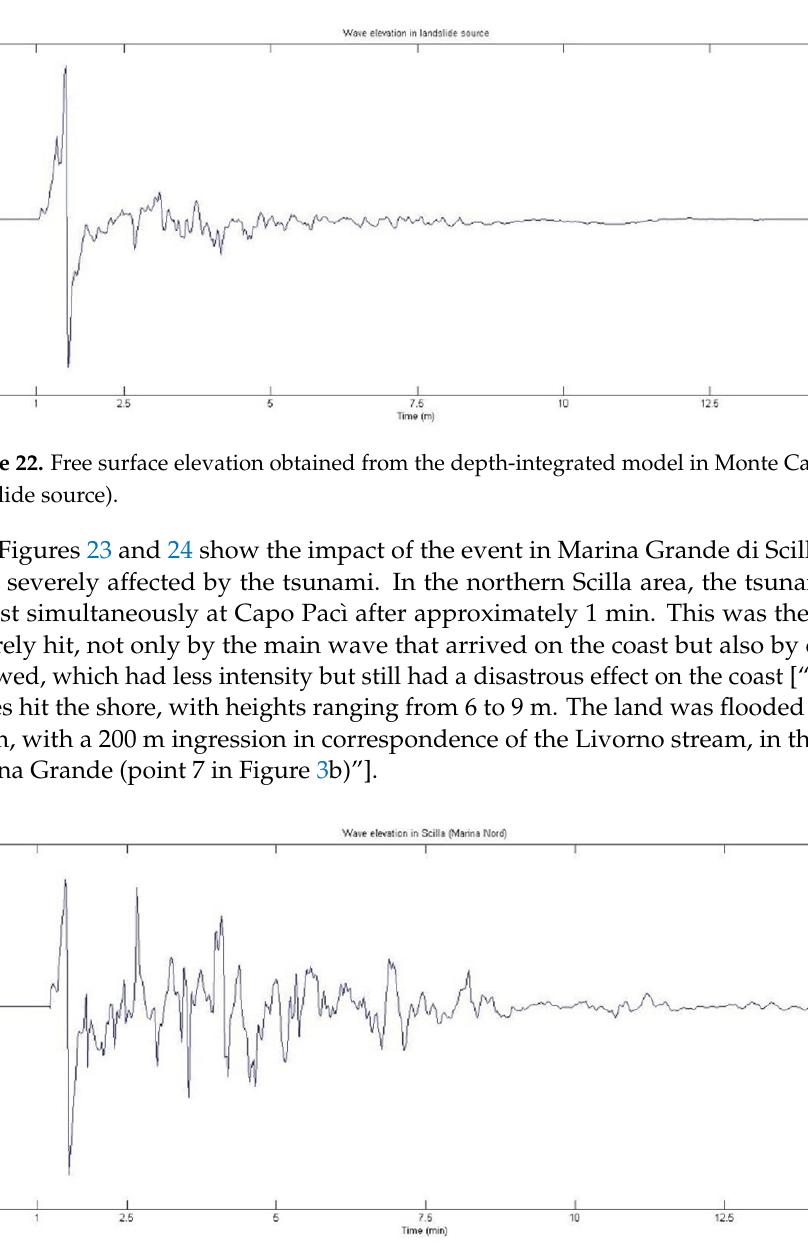
Figure 23. Free surface elevation obtained from the depth-integrated model in Scilla Marina Grande Nord.